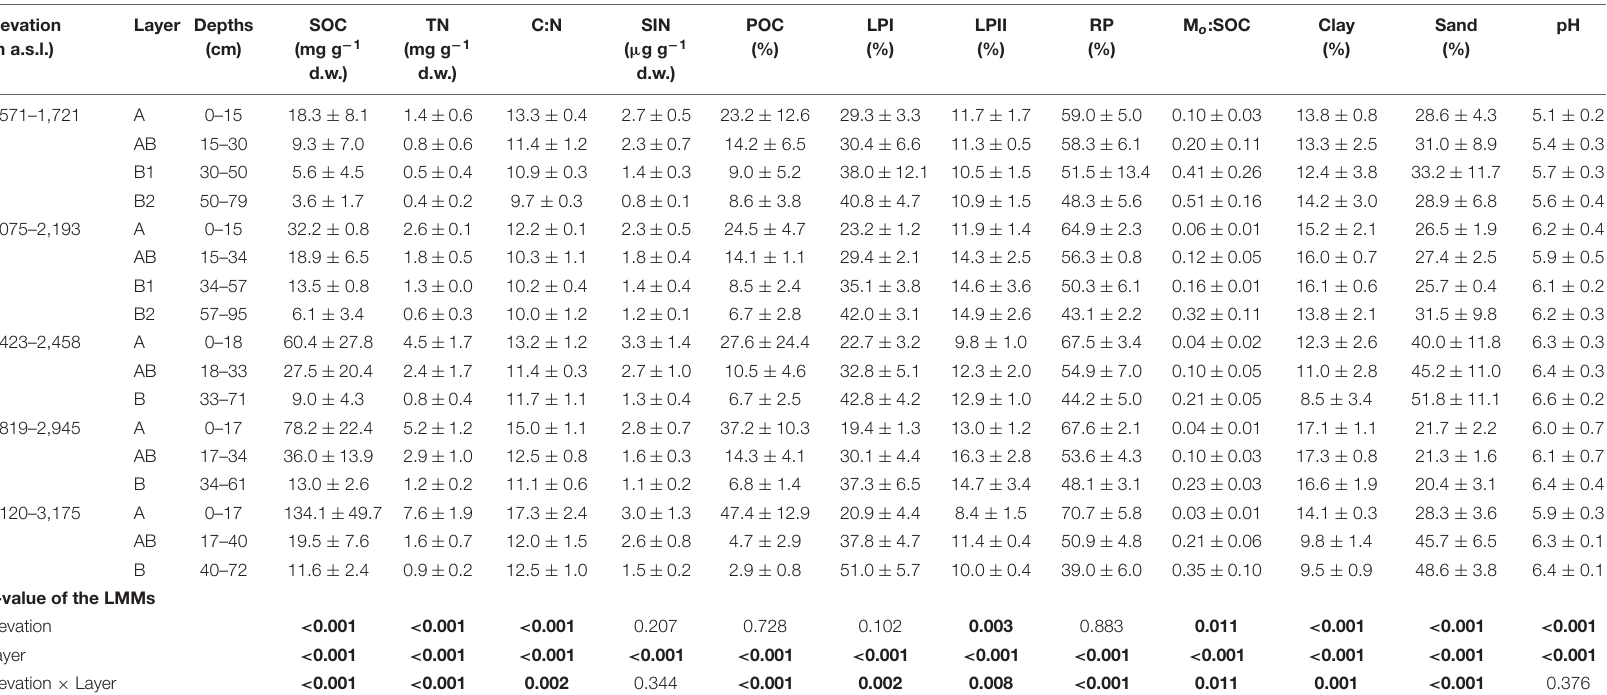
Results are means ± standard deviations for n = 3. The bottom half of the table shows the effects of forest type and soil layer on the parameters by using linear mixed models (LMMs). Numbers in bold indicate significant effects with p < 0.05. d.w., dry weight of soil; SIN, soil inorganic nitrogen (NH 4 + + NO 3 − ); POC, particulate soil organic carbon; LPI, labile carbon pool I; LPII, labile carbon pool II; RP, recalcitrant carbon pool; M o :SOC, mole ratio of poorly crystallized Fe and Al to